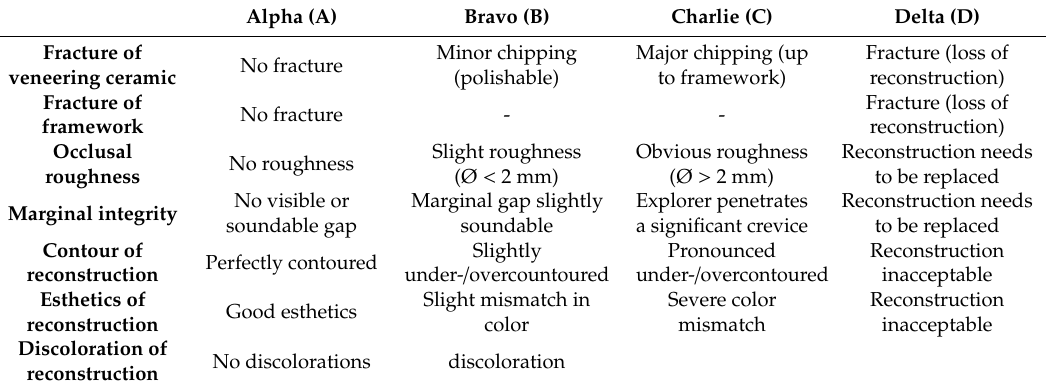
Table 1. Modified United States Public Health Service (USPHS) criteria for the analysis of single crowns and fixed dental prostheses